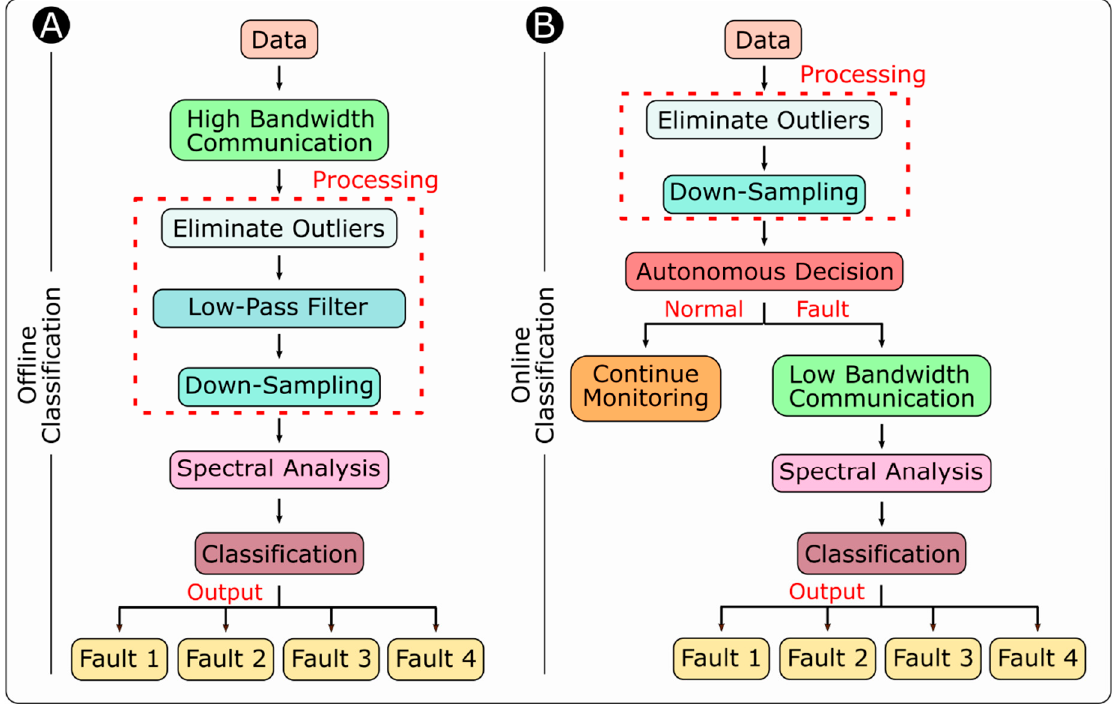
Figure 4. Overview of the signal-processing components for ( A ) Offline Classification and ( B ) Online Classification.